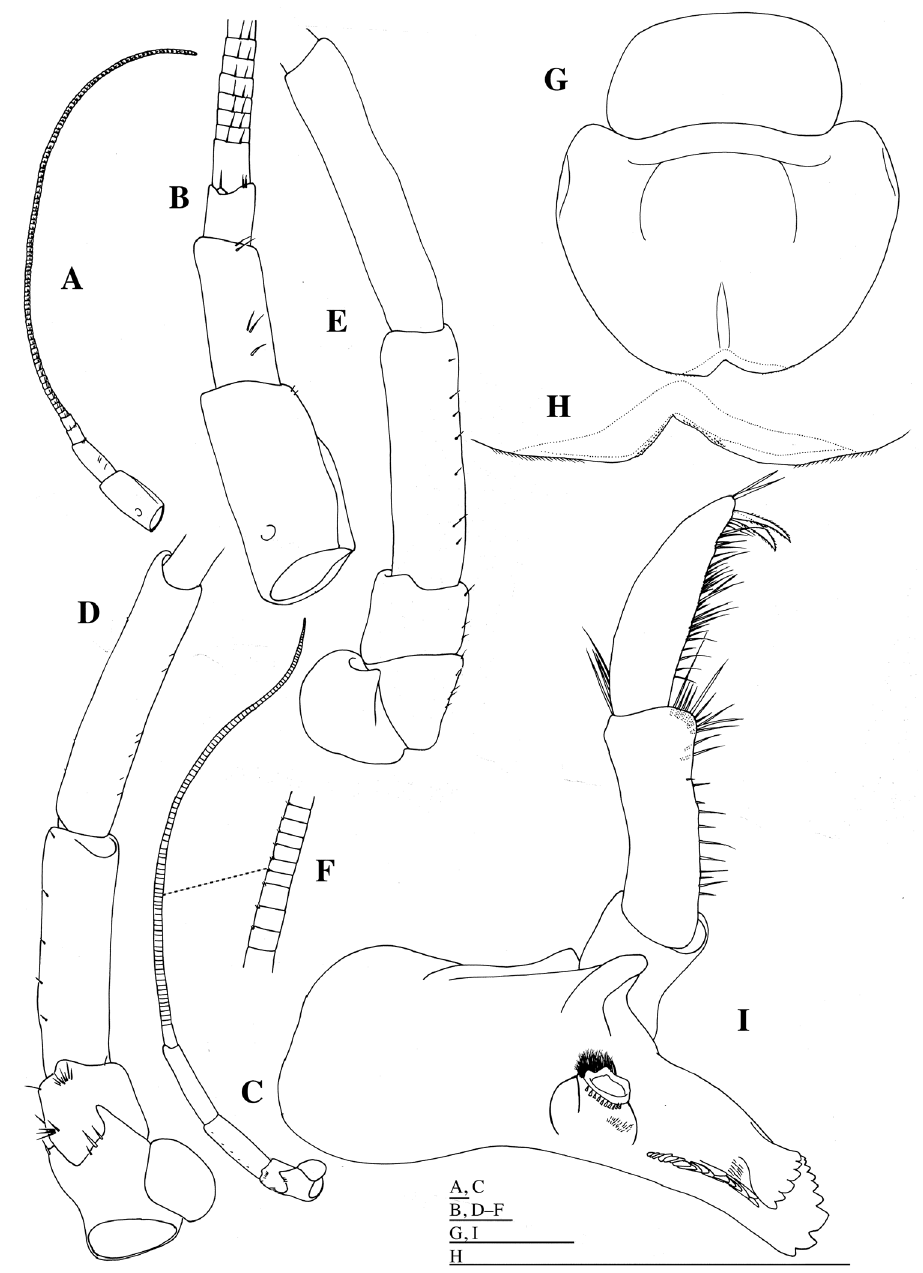
Figure 2. Epimeria abyssalis sp. n., holotype female: A left antenna 1, medial B basal part of left antenna 1, medial C left antenna 2, medial D basal part of left antenna 2, medial E basal part of left antenna 2, lateral F flagella of left antenna 2, medial G labium, dorsal H anterior part of labium, dorsal I left man- dible, medial. Scale bars: 1